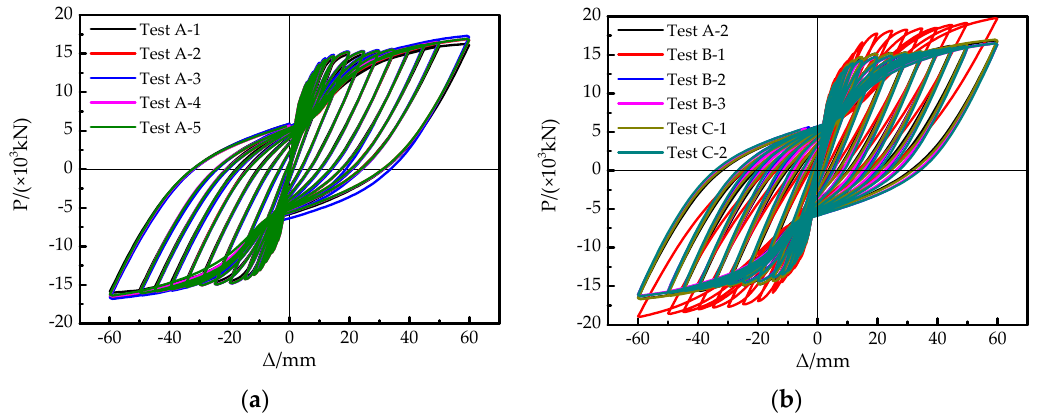
Figure 5. Lateral force–displacement hysteretic curves at pier top: ( a ) Layer divisions; ( b ) Mesh divisions.